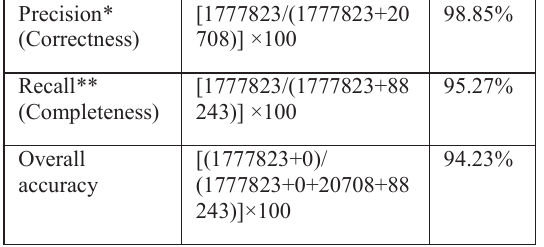
Table 2: Quantitative accuracy assessment of extracted road surface